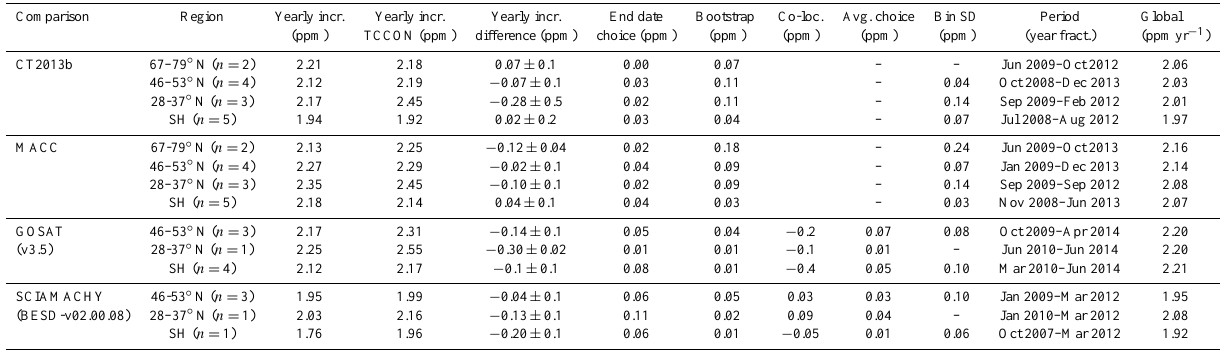
Table 4. Yearly increases. Each comparison uses matched pairs with TCCON using locations which have at least 2 years of data for com- parisons. See Table 3 for stations included. The start date and end date are averaged for the stations in each bin and are shown in the second to last column. Bold text shows one difference larger than predicted errors. The last column shows the average global yearly increase for the time period using Table